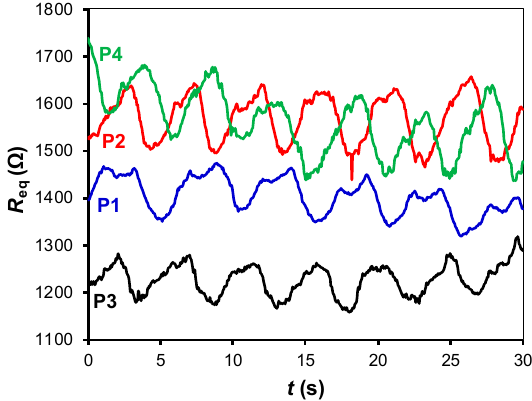
Figure 8. Small-signal resistance variations monitored by the DIC in Figure 2a for different values of the capacitor. The test was carried with subject S2 in the sitting posture P2, with f s = 20 Sa/s.